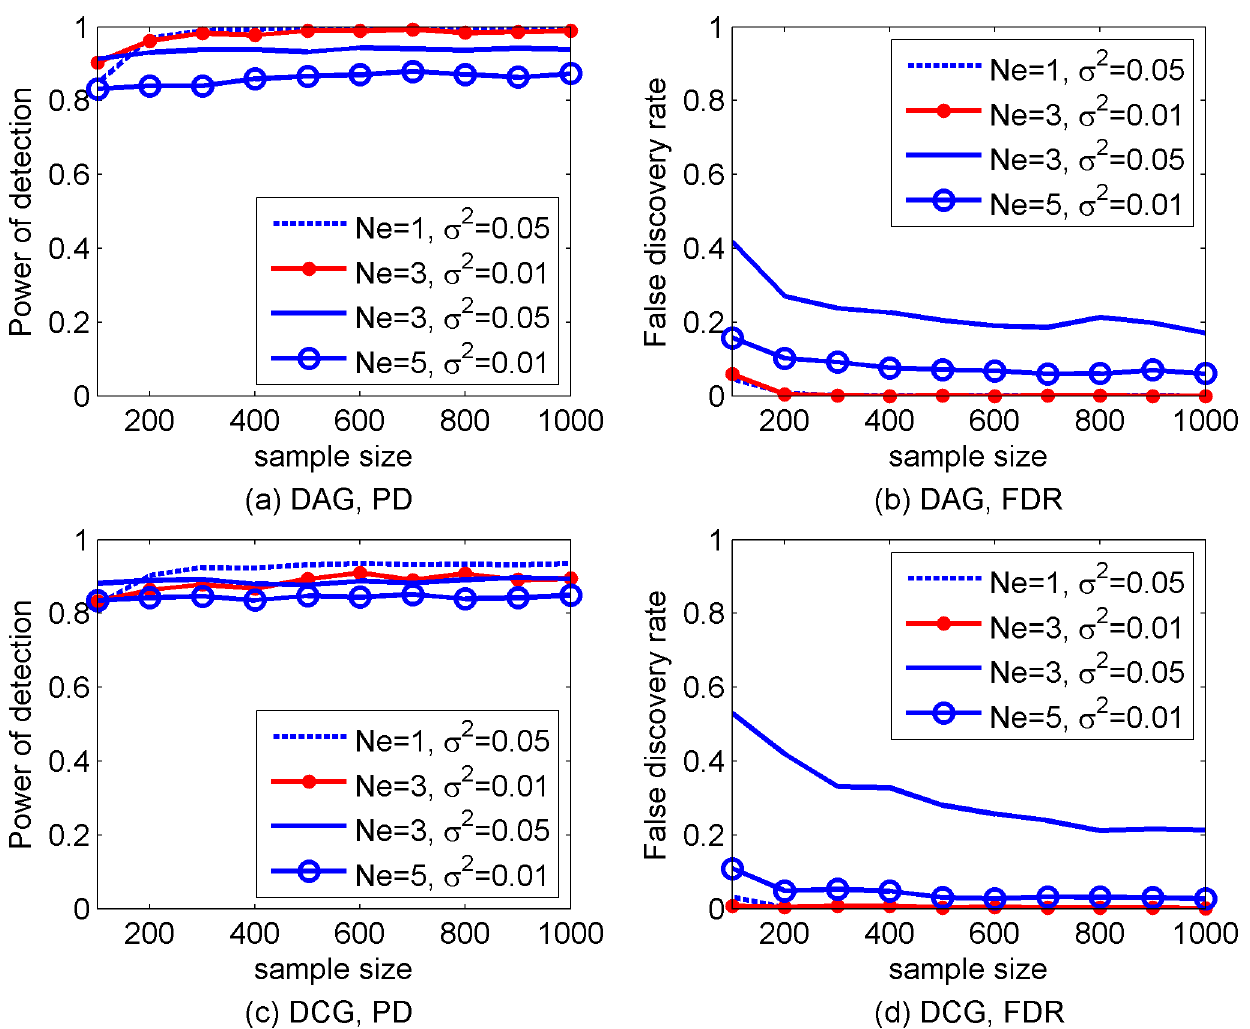
Figure 5. Performance of the SML algorithms for DAGs [(a) and (b)] or DCGs [(c) and (d)] of N g ~ 30 genes with an expected number of nodes per node N e [ f 1,3,5 g and error variance s 2 [ f 0 : 01,0 : 05 g . PD and FDR were obtained from 100 replicates of the network with different sample sizes ( N ~ 100 to 1,000).